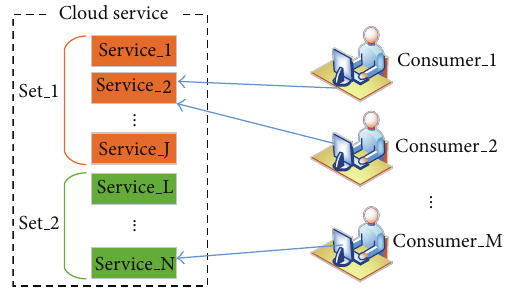
Figure 1: Cloud service selection